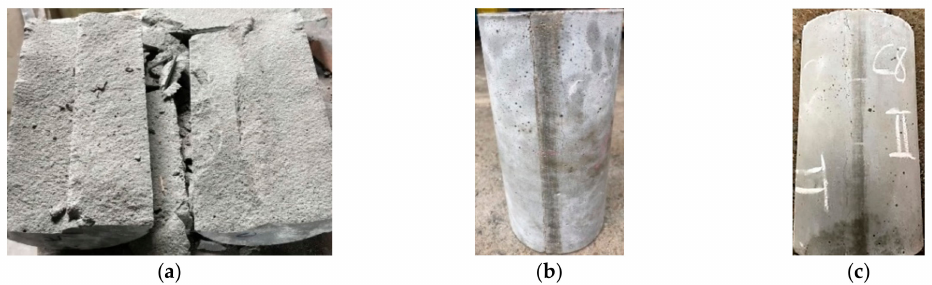
Figure 5. Comparison of splitting test results: ( a ) HPC-1, ( b ) UHPC-3, and ( c ) UHPC-5